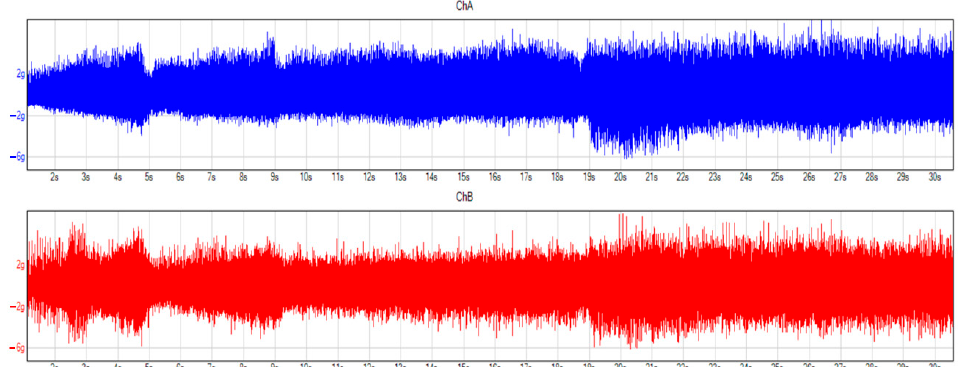
Figure 8. Vibrations in the frequency domain after the oil change.